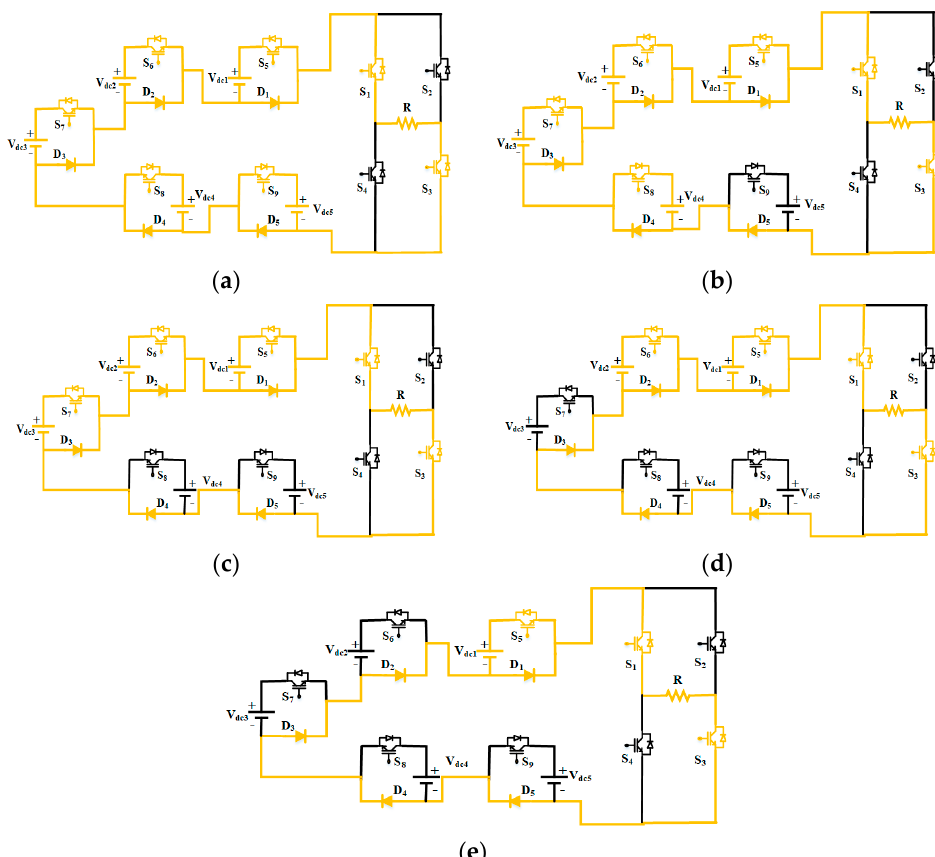
Figure 17 . ( a – e ) Equivalent circuit for different modes during positive cycle of output voltage . Similarly, the negative cycle operation occurs with S 2 and S 4 in the ON condition. The equivalent circuit for this mode is shown in Figure 18a–e.